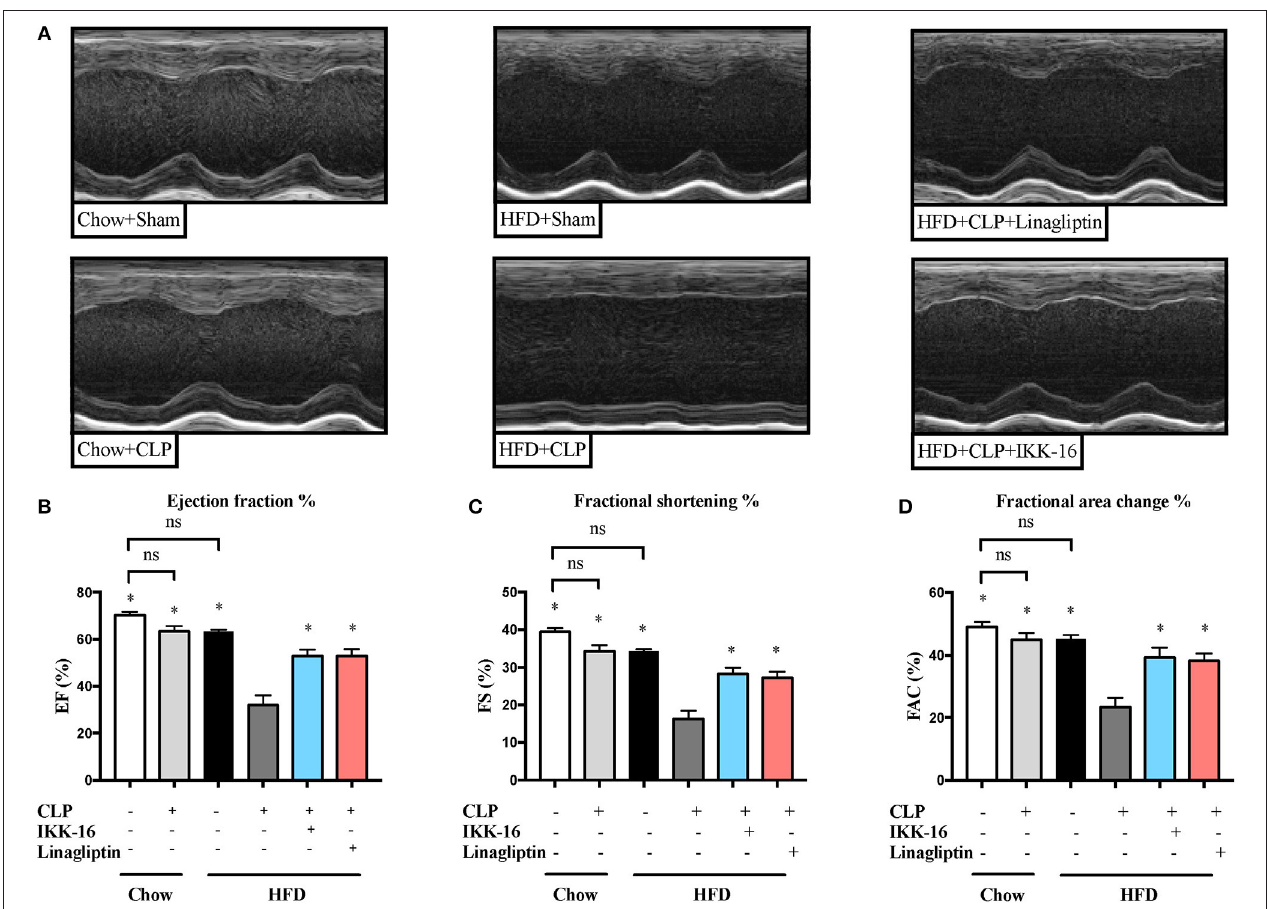
FIGURE 1 | Effects of CLP challenge and linagliptin or IKK-16 post treatment on cardiac function in mice with T2DM . Mice from chow and HFD groups were randomized to undergo CLP or sham surgery. At 1h after CLP, mice on HFD were randomized to receive linagliptin (10 mg/kg, i.v.), IKK-16 (1 mg/kg, i.v.), or vehicle (2% DMSO, 3 ml/kg). Cardiac function was assessed at 24h after CLP or sham surgery in mice fed a chow diet or a HFD. (A) Representative M-mode echocardiograms; percentage % (B) EF, (C) FS, and (D) FAC. Data was analyzed using one-way ANOVA followed by Bonferroni’s post-hoc test and expressed as mean ± SEM. * P < 0.05 compared to HFD + CLP group. ( n = 8 for sham surgery groups and 10 for CLP